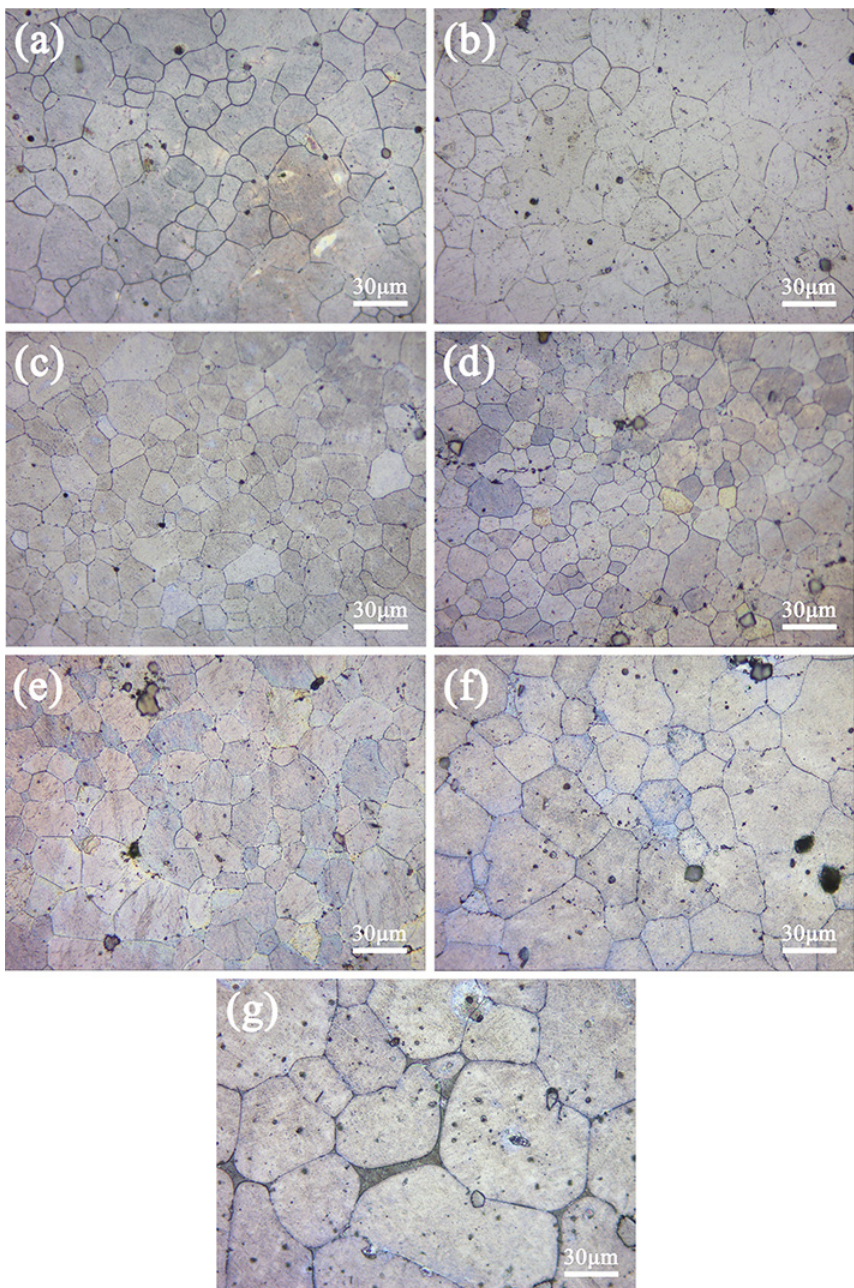
Figure 2. Optical micrographs of the single-aged ZTM641-xAl alloys, ( a ) x = 0, ( b ) x = 0.2, ( c ) x = 0.5, ( d ) x = 1, ( e ) x = 2, ( f ) x = 3 and ( g ) x = 4.